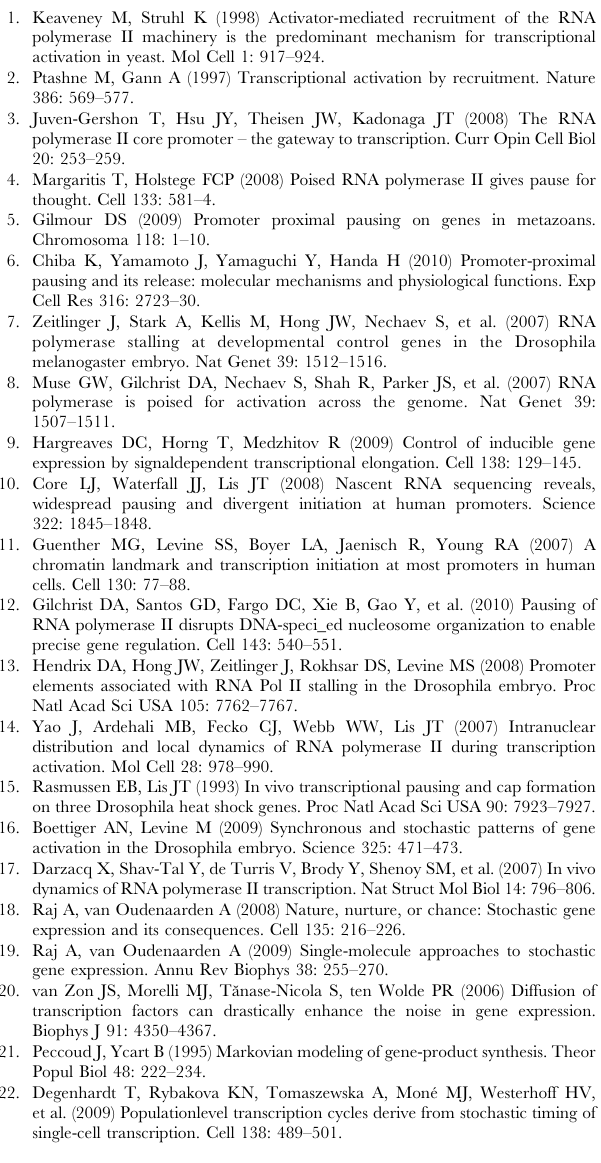
Figure S5 Sensitivity analysis for variance in transcription time. The details are the same as for Figure 4 in the text, except that the variance in transcription time is analyzed, rather than the mean transcription time. Figure S6 Sensitivity analysis for transcript count variability. The details are the same as for Figure 4 in the text, except that the transcript count variability is analyzed, rather than the mean transcription time. Found at: doi:10.1371/journal.pcbi.1001136.s006 (0.47 MB EPS) Text S1 Derivation of equations and detailed mathematical approach for rapid inversion of large transition